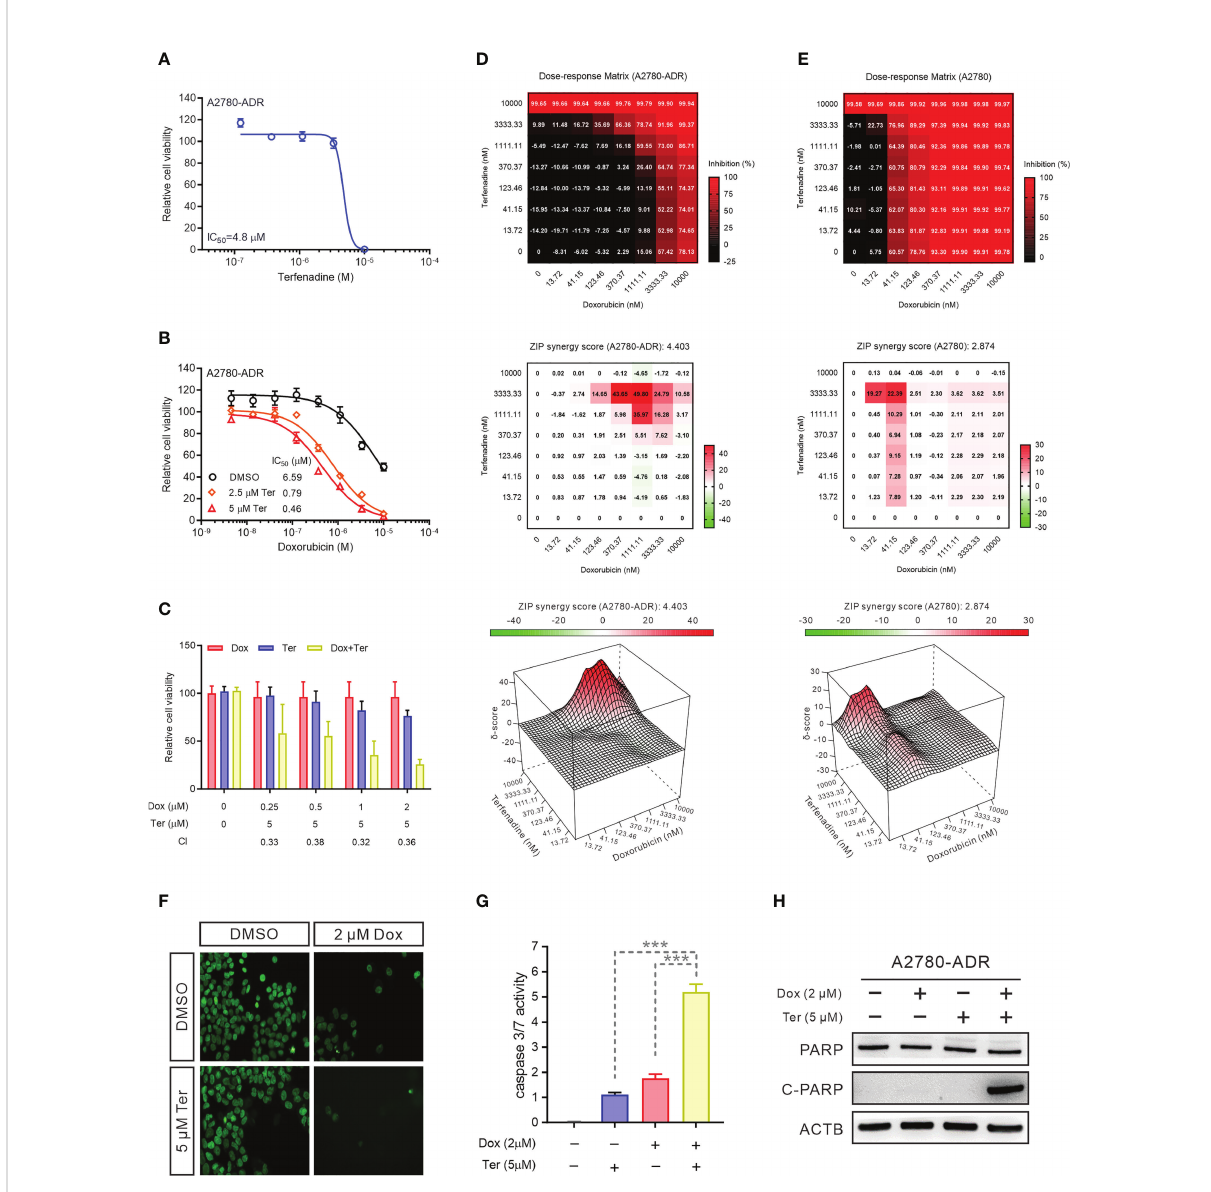
FIGURE 2 Terfenadine restores doxorubicin-induced apoptosis in MDR ovarian cancer cells (A) Terfenadine dose-response curves of MDR ovarian cancer cells. (B) Dose-response curves for doxorubicin in MDR ovarian cancer cells in the absence or presence of terfenadine (Ter). (C) A Bar graph showing the synergistic effects of terfenadine (Ter) and doxorubicin (Dox) on MDR ovarian cancer cells. Calculated CI values are presented below the plots. (D, E) Synergy matrixes (bottom) and surface plots (top) show the synergy between doxorubicin and terfenadine on A2780 (D) and A2780-ADR (E) cells (n = 3). (F) Nuclear staining of MDR ovarian cancer cells treated with the indicated concentration of doxorubicin (Dox), terfenadine (Ter) or both. DMSO was used as a non-treated control. (G) Caspase3/7 activity in MDR ovarian cancer cells treated with the indicated concentration of doxorubicin (Dox), terfenadine (Ter) or both. DMSO was used as a non-treated control. (H) Western blot analysis of PARP in MDR ovarian cancer cells after treated with 2 m M doxorubicin (Dox), 5 m M terfenadine (Ter), or both for 24 h. ACTB was used as the loading control. All values represent the mean ± SEM (n = 3 replicates). Western blot images were shown as one of three repeated experiments. Statistical analysis was performed using two tailed t-test (*** p <